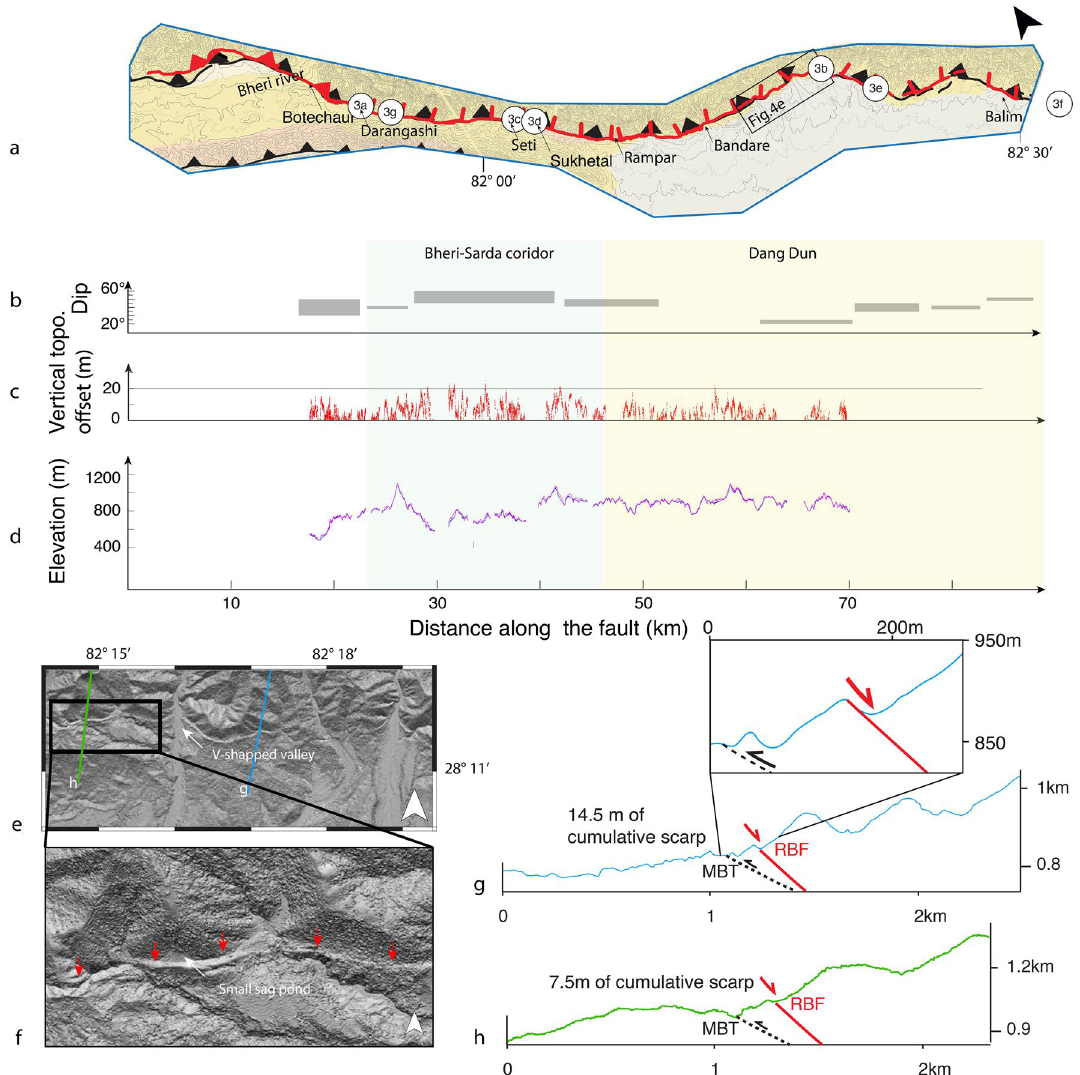
Figure 4. ( a ) Expanded view of the tectonic map of the Surkhet-Gorahi segment of the Reactivated Boundary Fault with location of field pictures from Fig. 3. ( b ) Dips derived from V shaped valley and field measurements on the fault ( c ) Vertical offset of the cumulative scarp topography or ridge height and ( d ) Elevation of the top (red) and bottom (blue) of the cumulative scarp or ridge. ( e,f ) Digital elevation model near the fault 0.5 m resolution. Red arrows locate the fault trace. ( g,f ) Topographic profiles across the fault trace located on ( e ). Digital elevation model near the fault 0.5 m resolution. Figure generated with ENVI Classic (https:// www. l3har risge ospat ial. com/ Softw are- Techn ology/ ENVI) and Adobe illustrator CS6 (http:// www. adobe. com/ fr/ produ cts/ illus trator.